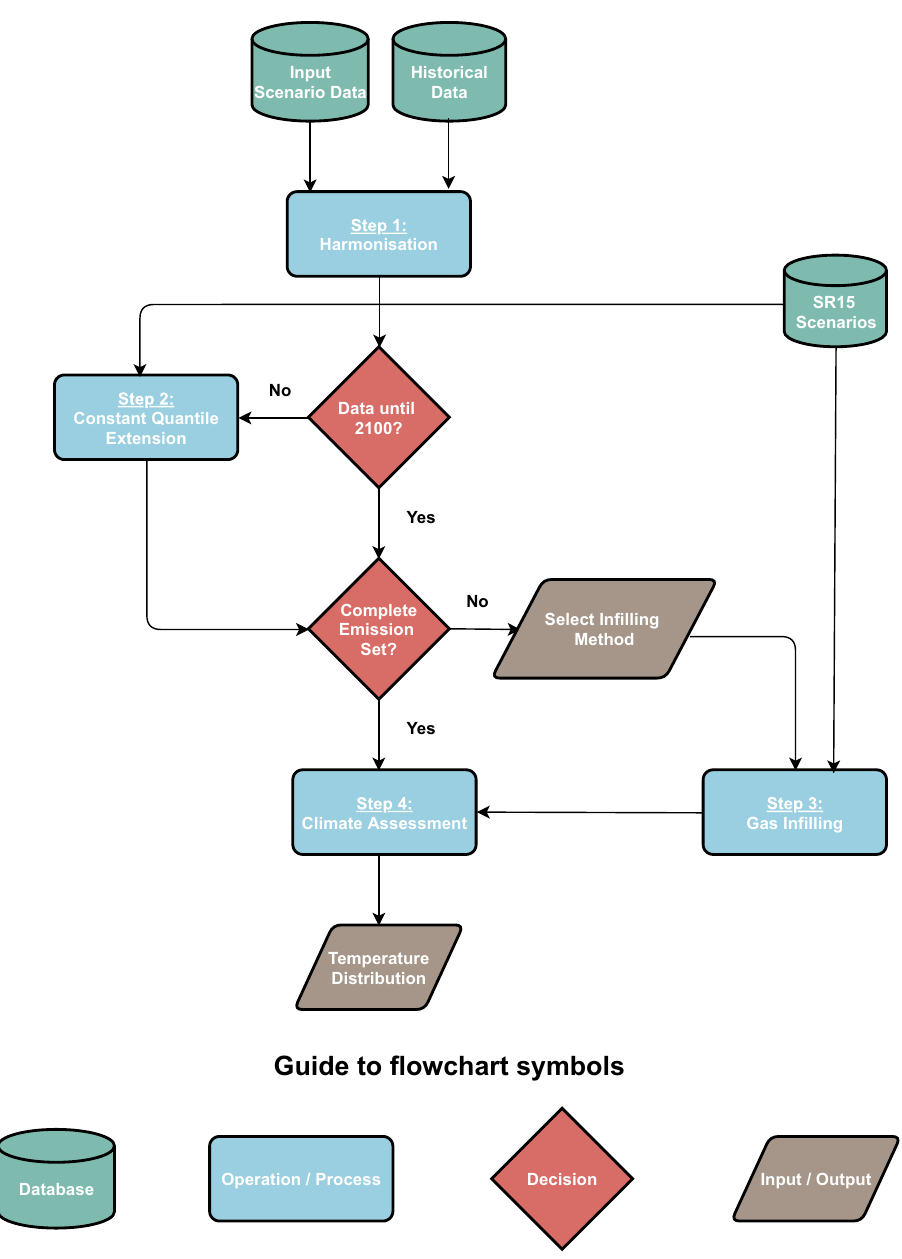
Fig. 1 Schematic diagram of the assessment framework. The input scenario data refers to the institutional scenario data assessed in this study. The schematic is composed of database inputs (institutional scenario data, data from the scenarios underlying the IPCC ’ s Special Report on 1.5 °C), data processing steps, decision steps that lead to the application of certain steps, as well as user-de fi ned inputs, and outputs of the